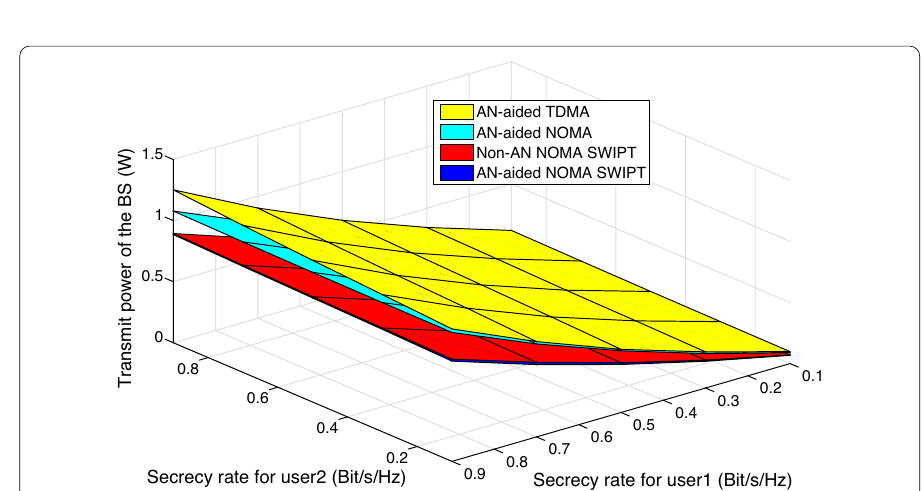
Fig. 4 The minimum transmission power of the BS versus the secrecy rates under different